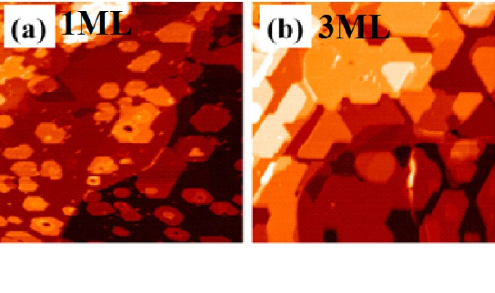
Figure 4. ( a ) 250 × 250 nm 2 STM images for θ = 1 ML of Eu deposited on graphene at RT with a deposition rate 0.2 ML/min. The islands are large and crystalline of main height 0.75 nm with well-defined facets; ( b ) The film closes in a layer-by-layer fashion if